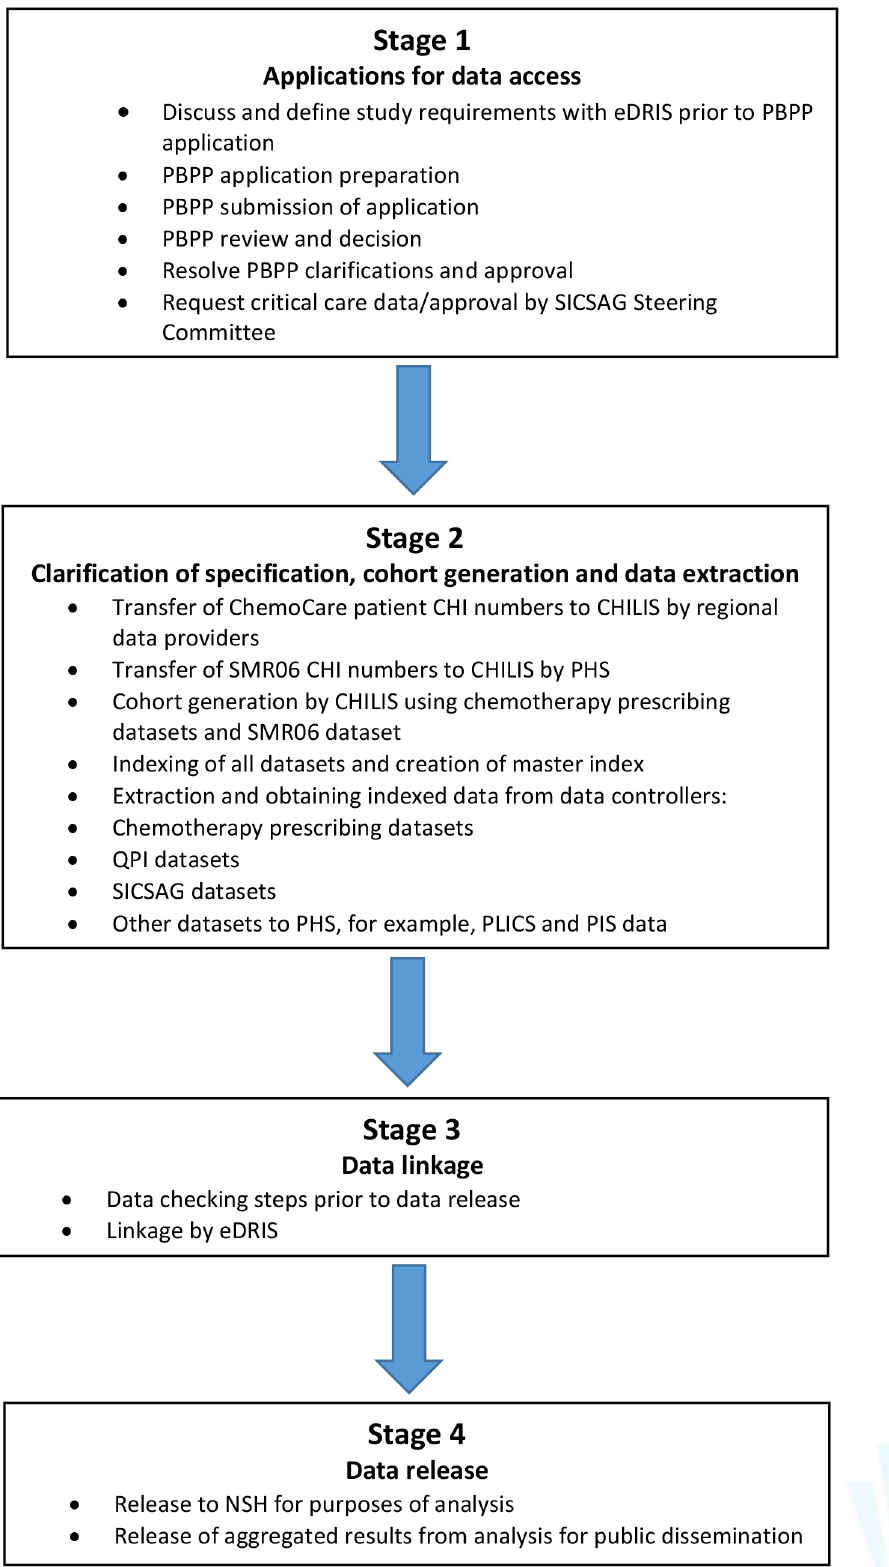
Figure 1: Flowchart outlining the main stages to access and link